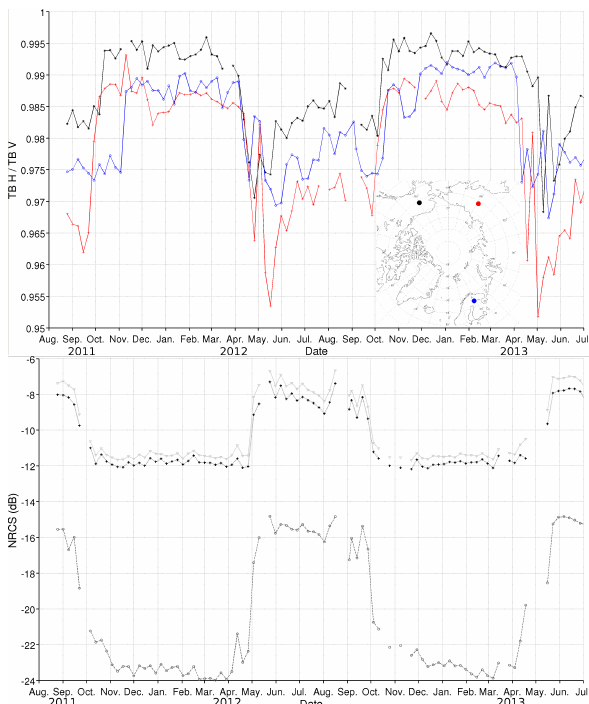
Fig. 16. (Top) time series of the TB H/V ratio in three locations: Northern America (Alaska) 66 o N, 150 o W (black *), Northern Europe (Finland) 67.5 o N, 29 o E (blue o), and Asia (Russia) 66 o N, 149.5 o E (red +). (Bottom) time series of NRCS at (from top to bottom) HH (continuous line, downward triangles), VV (dotted line, plus symbols), and VH (dashed line, circles) for the location in Asia.